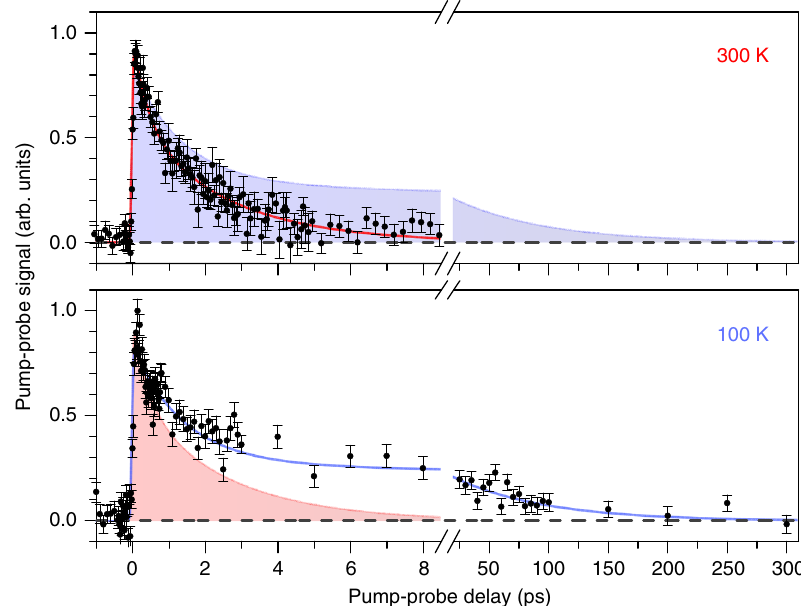
Fig. 3 Pump-probe signal as a function of the pump-probe delay at 300 and 100 K. The excited-state decay of retinal protonated Schiff-base (RPSB) at two temperatures. Upper graph: Two-photon signal as a function of delay between pump (600 nm) and probe (800 nm) pulses, recorded at 300 K. Lifetimes of about 400fs and 3 ps are here deduced. Lower graph: Same as upper graph, but recorded at 100 K where the lifetimes are 1.4 and 77 ps. The shaded areas are shown to provide a cross-comparison with the data obtained at the other temperature. All error bars presented are one standard deviation